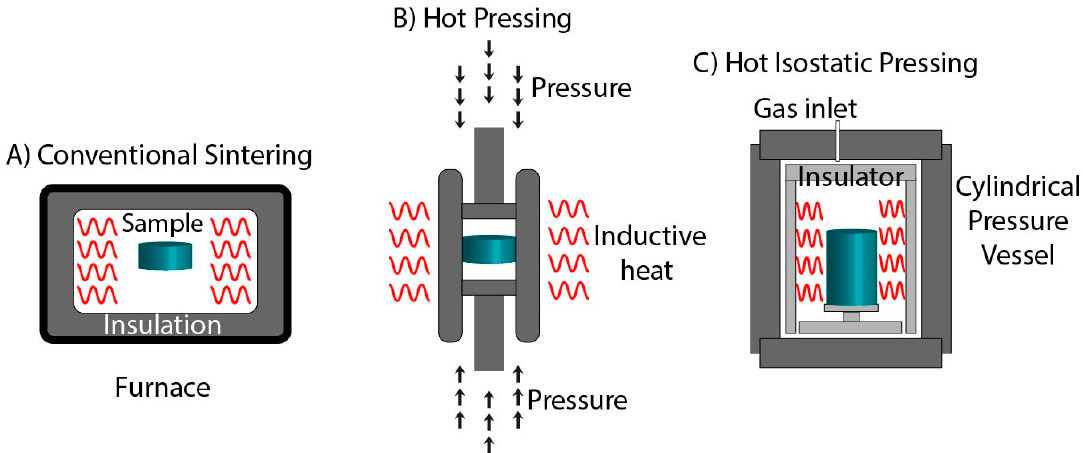
Figure 2. Schematic representation of ( A ) Conventional sintering, ( B ) Hot pressing, and ( C ) Hot Isostatic pressing.